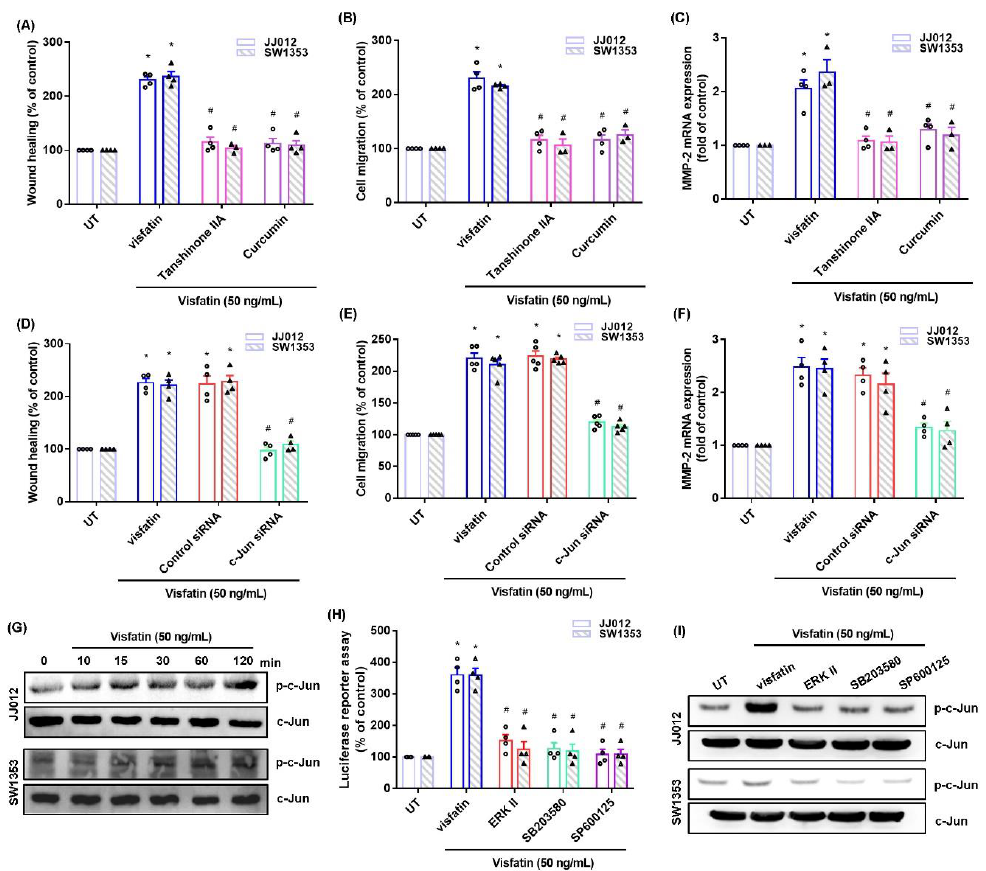
Figure 5. Visfatin induces MMP-2 production and cell migration through AP-1 activation in chondrosarcoma cells. ( A – F ) Cells were pretreated with AP-1 inhibitors (tanshinone IIA or curcumin) or transfected with a c-Jun siRNA, then stimulated with visfatin. Cell migration and levels of MMP-2 expression were examined by Transwell, wound healing, and qPCR. ( G ) Cells were incubated with visfatin for the indicated time intervals; c-Jun phosphorylation was examined by Western blot. ( H , I ) Cells were treated with indicated inhibitors then stimulated visfatin, the c-Jun phosphorylation and AP-1 luciferase activity was examined. Quantitative results are expressed as the mean ± SD. All experiments were repeated 3 to 5 times. * p < 0.05 compared with the UT group; # p < 0.05 compared with the visfatin-treated group. UT, untreated